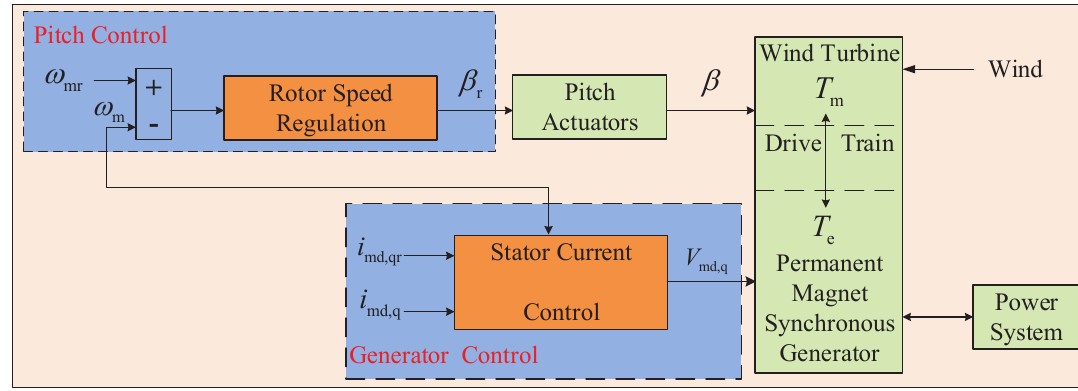
Figure 3. Brief overall control structure of the